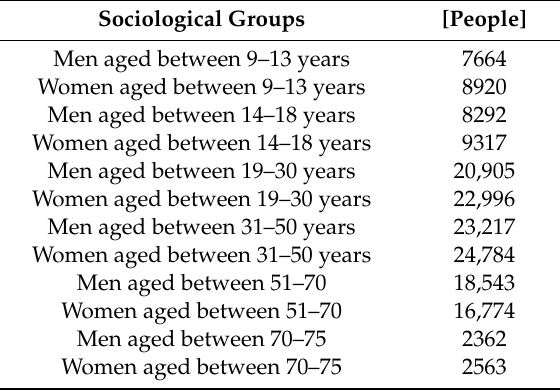
Table 5. Number of people by population